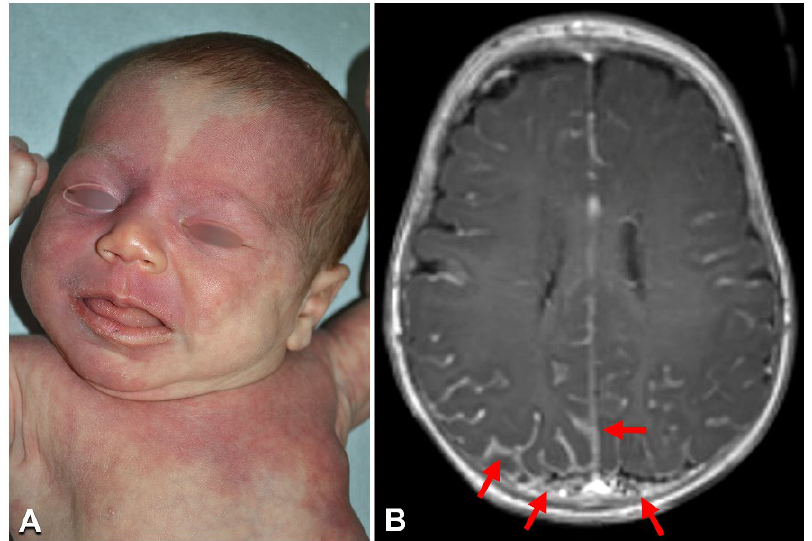
Figure 1. Clinical imaging of Sturge–Weber syndrome: A 2-month-old female (Table 1, n. 2) with a diffuse capillary malformation of the trunk, limbs, and face, where the upper eyelids and forehead are involved ( A ); brain MRI documenting the leptomeningeal angiomatosis (arrows in B ) ( B ).